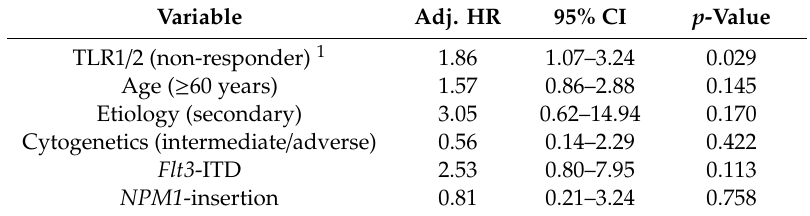
Table 1. Multivariate analysis with adjusted hazard ratio for parameters associated with AML prognosis.